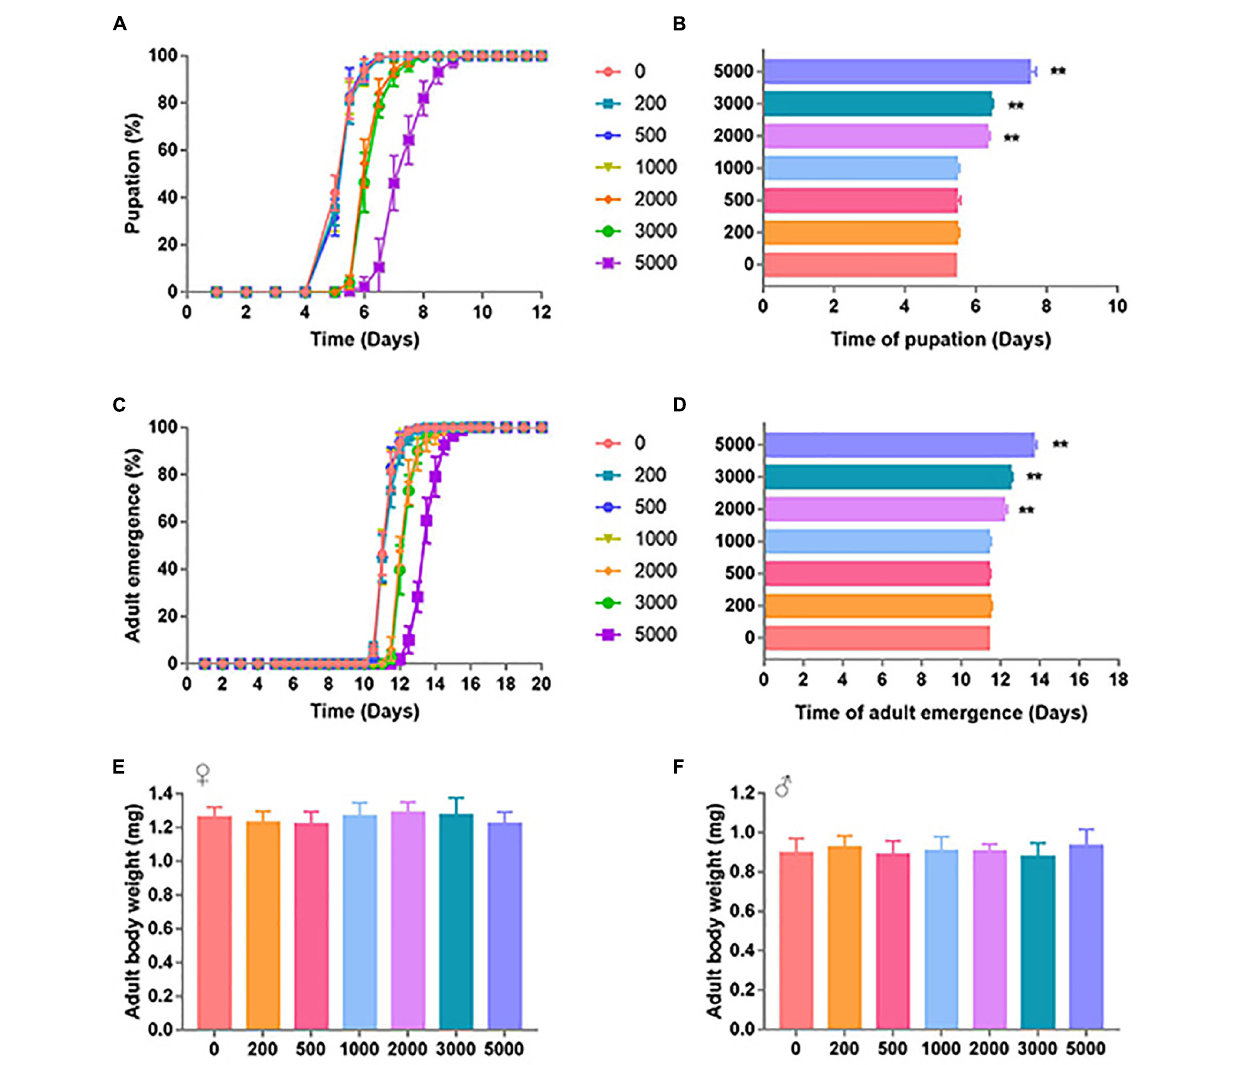
FIGURE 1 | Development timing of SB-supplemented flies. (A) Pupation time of flies fed with SB. (B) Mean time of the pupation of flies fed with SB at 0, 200, 500, 1,000, 2,000, 3,000, and 5,000 ppm. (C) Adult emergence time of flies fed with SB. (D) Mean time of the adult emergence time of flies fed with 0, 200, 500, 1,000, 2,000, 3,000, and 5,000 ppm of SB. (E) Adult body weight of females fed with 0, 200, 500, 1,000, 2,000, 3,000, and 5,000 ppm of SB. (F) Adult body weight of males fed with 0, 200, 500, 1,000, 2,000, 3,000, and 5,000 ppm of SB. ** p < 0.01.